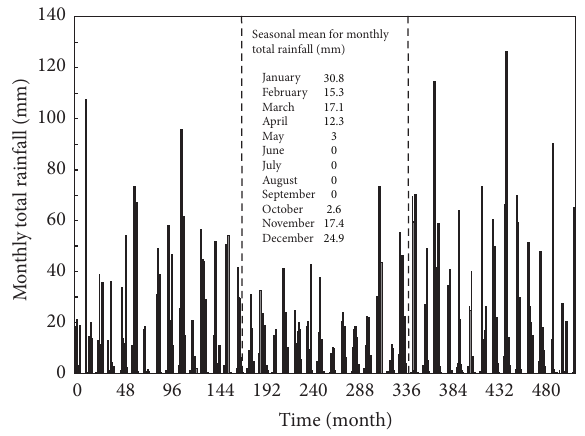
Figure 2: Rainfall data available from the weather station located at Kuwait International Airport for the time duration from January 1967 (month number 1) to December 2009 (month number 516). The two dashed lines are used to divide the rainfall data into three distinct equal time intervals, at April 1981 (month number 172) and August 1995 (month number